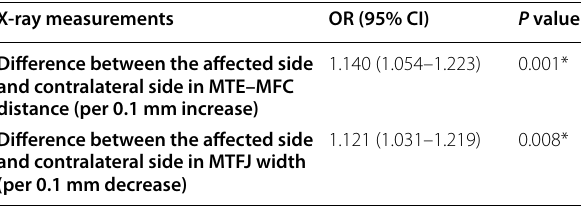
Table 3 Univariate logistic regression analysis of X-ray measurements for